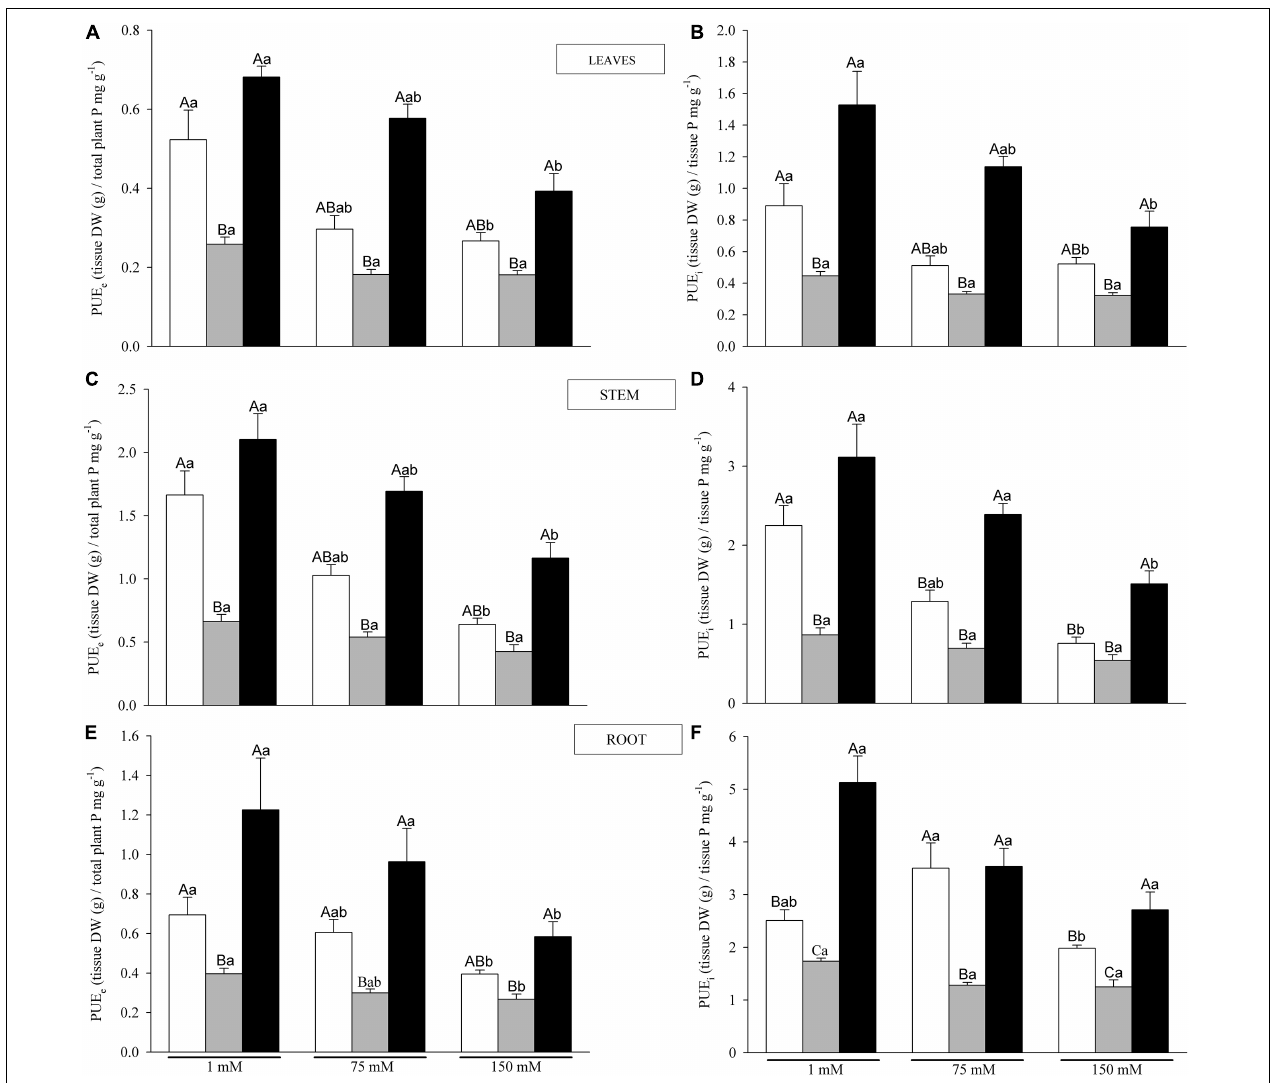
FIGURE 6 | Phosphorus use efficiency external and internal (PUE e and PUE i , respectively), of leaves (A,B) , shoots (C,D) and roots (E,F) , for C, P and AM plants (white, gray and black bars, respectively) under 1, 75 and 150 mM NaCl. Values are mean and standard error of at least four replicates per treatment. Different capital letters indicate significant differences among nutritional levels (C, P and AM) within the same salt level, and lowercase letters indicate significant differences among salt levels within the same nutritional level, from post hoc Tukey